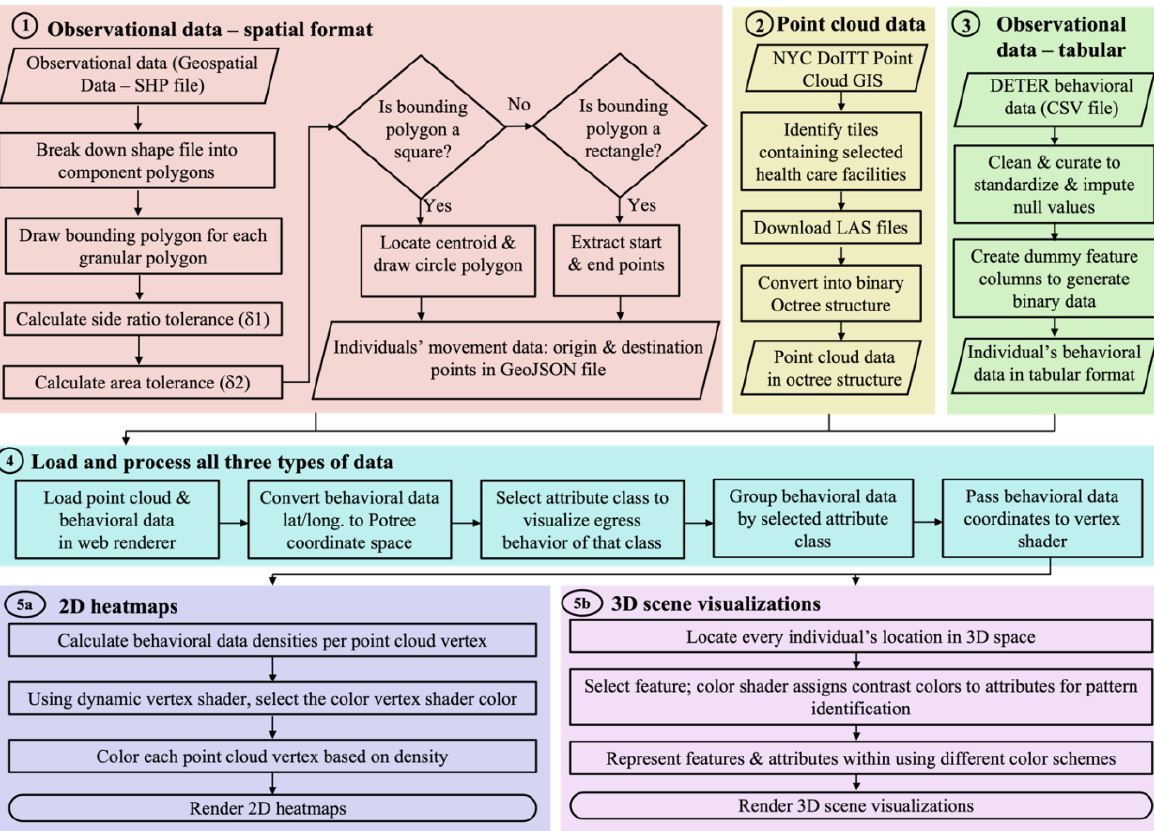
Figure 1. Flow chart of proposed methodology (Sections 2 and 4 adapted from Carey et al., 2021)